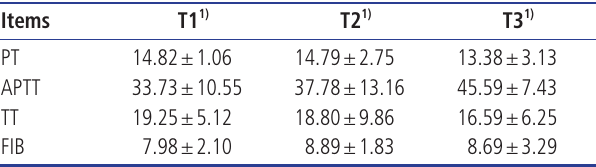
Table 5. Effect of mulberry leaves on coagulation parameters of Sprague- Dawley rats at the end of the recovery period